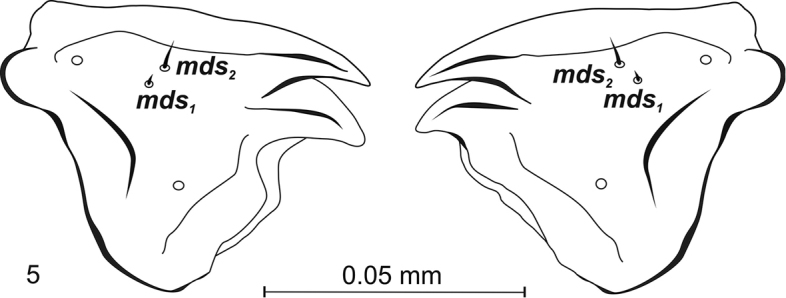
Squamapion
atomarium (L3) – mandibulae.